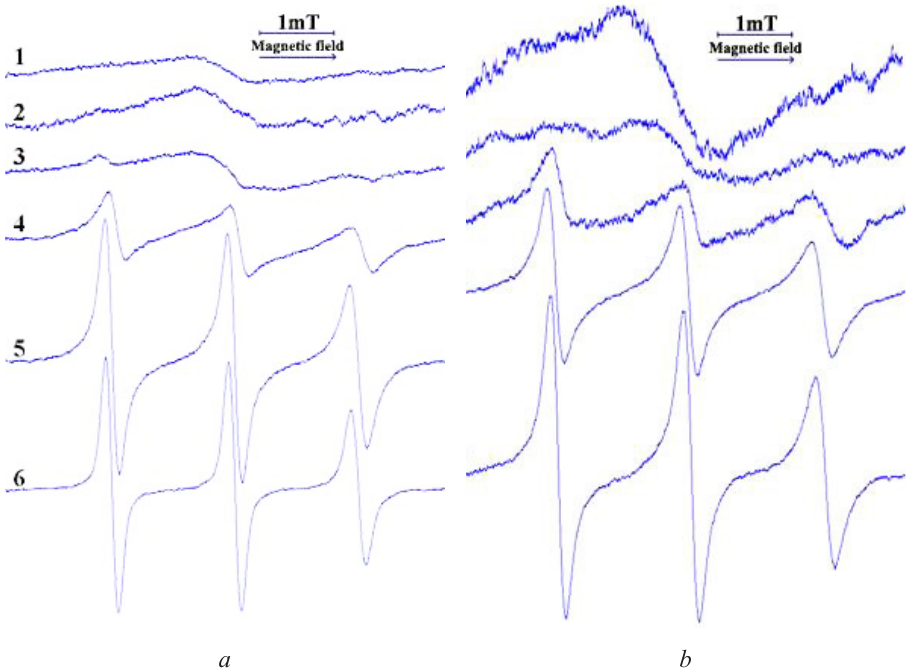
Fig. 2. EPR spectra of lipophilic probe 2 in: a – water (1) and aqueous solutions of BC at concentration: 2 – 0.05 %, 3 – 0.1 %, 4 – 0.15 % (CMC) , 5 – 0.3 %, 6 – 1.0 %; b – aqueous solutions containing: 1 – 0.5 % DSE, 2 – 0.5 % DSE+0.025 %